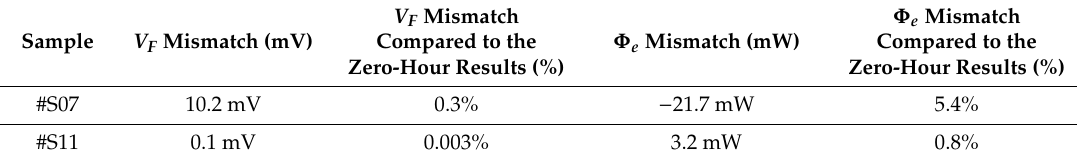
Table 4. The error made by the model compared to the measurement results at 4340